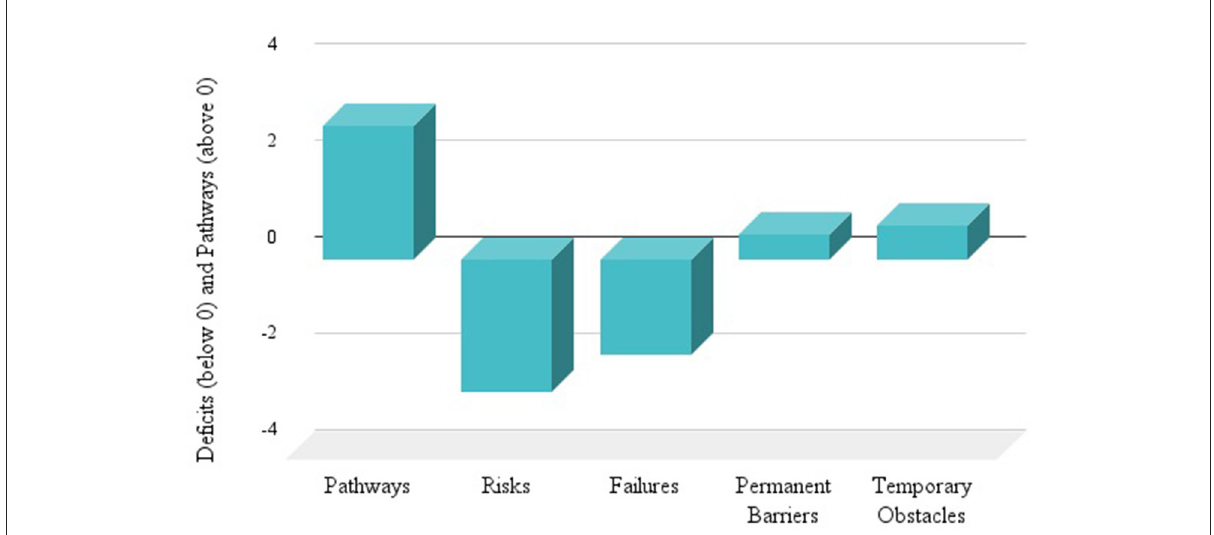
FIGURE3 Comparison of Accessible Pathways and Features—shows the average pathway rating as a positive score and contrasts it to the average ratings of observed access risks and failures, permanent barriers, and temporary obstacles per community shows as deficits along the negative scale. Permanent barriers and temporary obstacles contribute to Access Failures. Access Risks and Failures reduce the Pathway Score.